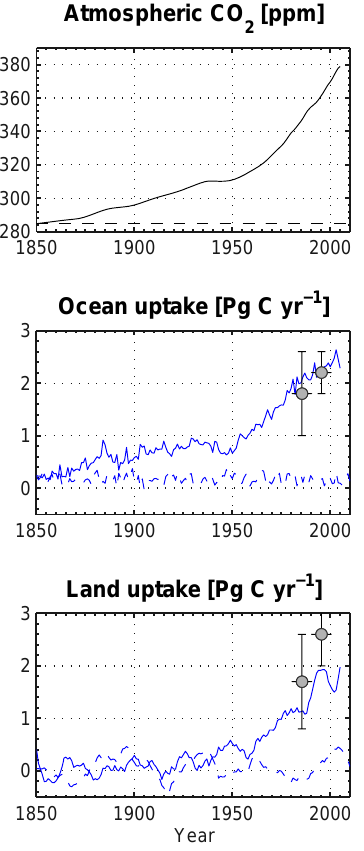
Fig. 21. Time series of atmospheric CO 2 concentration (upper panel), annual oceanic carbon uptake (middle panel), and land (bot- tom panel) carbon uptake (excluding land use change) simulated over the historical period. Solid lines represent value from HIST, whereas dashed lines represent value from CTRL (shown here only for the first 156yr) simulations. Five-years running mean are ap- plied to the land uptake fields. The observation estimates (grey cir- cles) are from Denman et al.